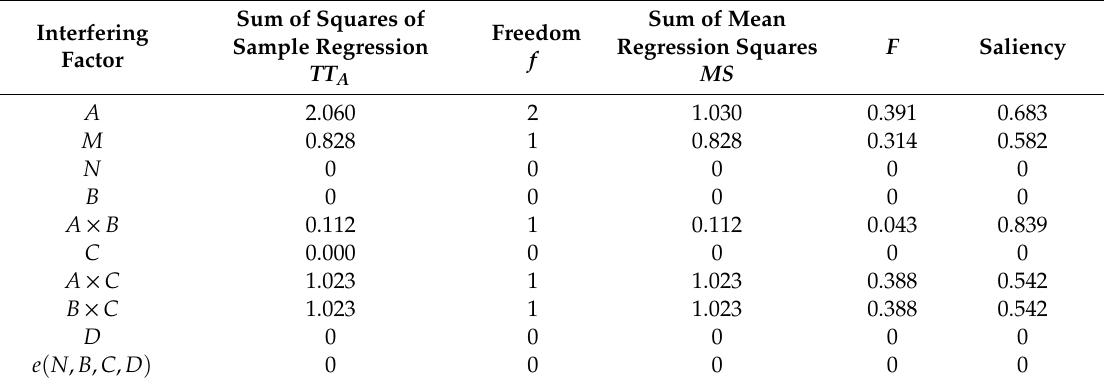
Table 11. Results of sample regression variance